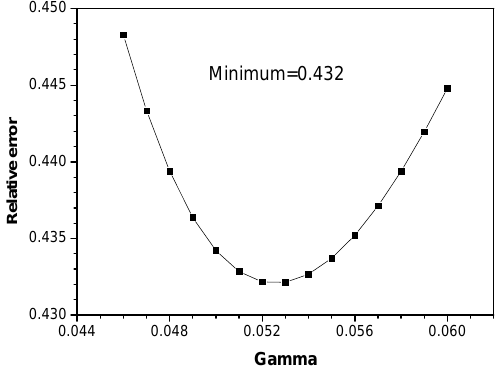
Fig. 6. Relative error variance for different constraint strengths.